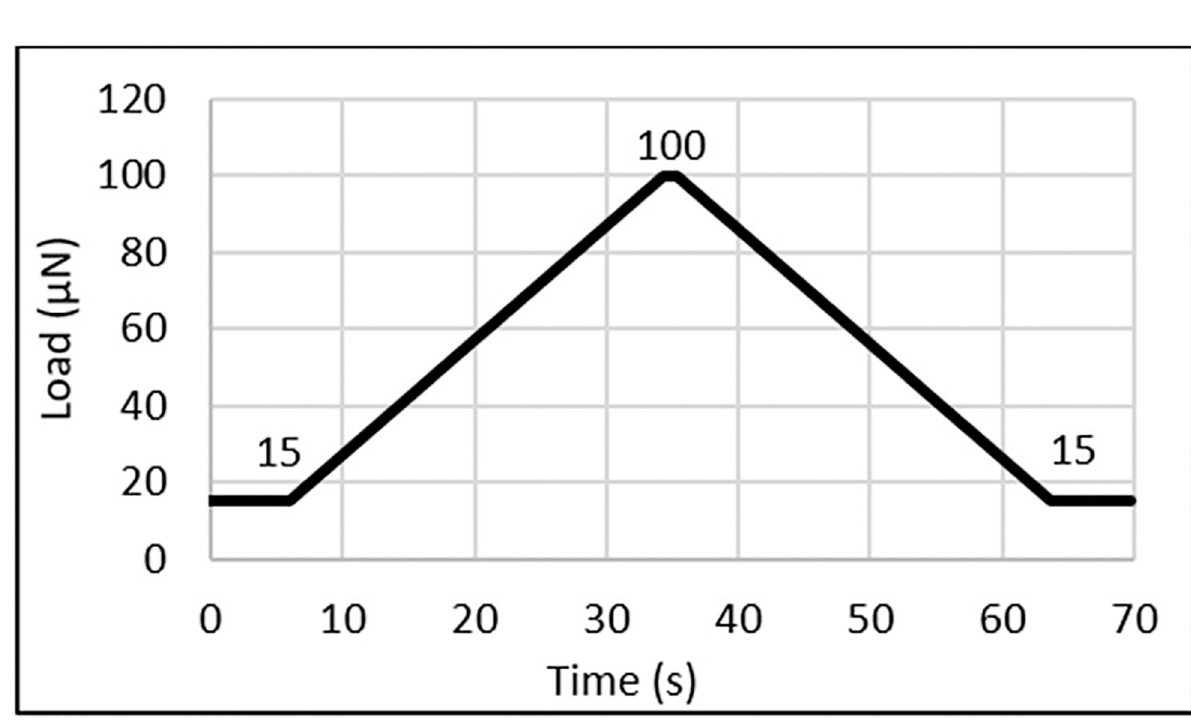
Fig 4. The plot shows the nanoindentation load function used for testing the samples where the y-axis is the load, and the x-axis is elapsed time during the test.